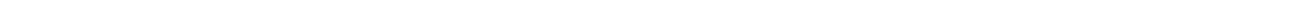
Fig. 7 Occupancy and mean lifetimes of latent brain states predict WM performance. a A multiple linear regression model was trained using occupancy rates of latent brain states in the 2-back task to predict WM accuracy. A signi fi cant association was observed and predicted accuracies were correlated with observed accuracy in both sessions: (Session 1: r = 0.30, p < 0.001; Session 2: r = 0.34, p < 0.001, Pearson ’ s correlation). b Occupancy rate of the latent brain state SH which dominates the 2-back WM task condition was correlated with WM task accuracy in both sessions (Session 1: r = 0.39, p < 0.001; Session 2: r = 0.31, p < 0.001, Pearson ’ s correlation). No such relations were found for any of the other latent states. c A multiple linear regression model was trained using mean lifetimes of latent brain states in the 2-back task to predict WM accuracy. Here again, a signi fi cant association was found and the predicted accuracy was correlated with observed accuracy in both sessions (Session 1: r = 0.28, p < 0.005; Session 2: r = 0.35, p < 0.001, Pearson ’ s correlation). d Mean lifetime of the latent brain state SH which dominates the 2-back WM task condition was correlated with WM task accuracy in both sessions (Session 1: r = 0.37, p < 0.001; Session 2: r = 0.27, p < 0.005, Pearson ’ s correlation). No such relations were found for any of the other latent states. Shaded area represents 95% con fi dence interval. Color code mapping in b and d : dark blue — SL, cyan — SH, yellow — ST, red —